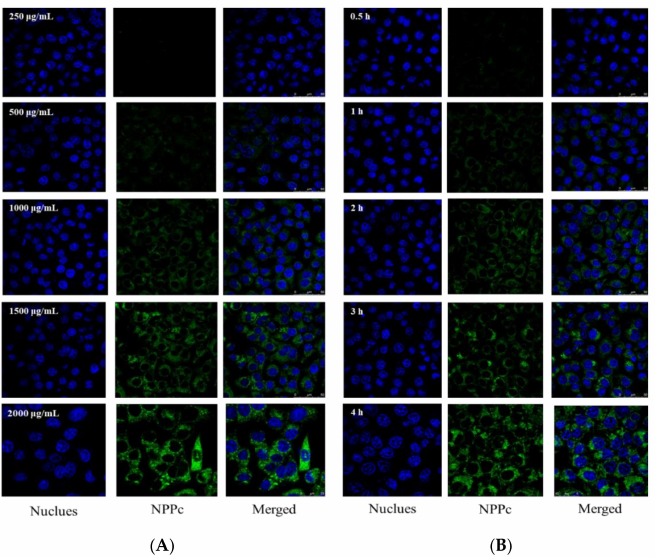
Figure 5. Localizations of NPPc in Caco-2 cells with various concentrations ( A ) and time intervals ( B ) by a laser scanning fluorescence microscope.